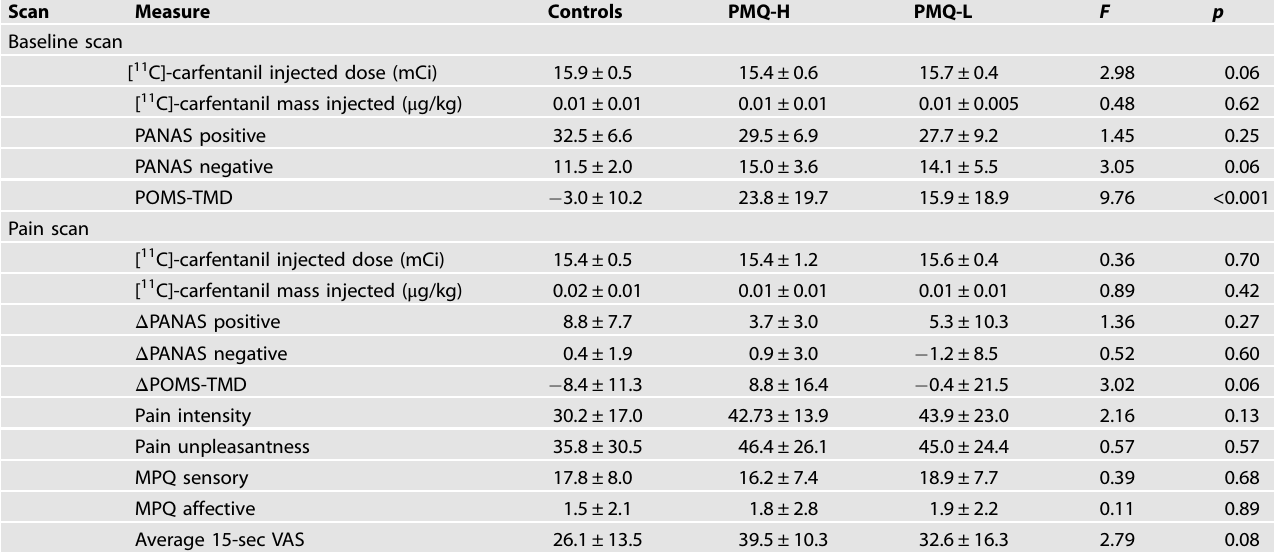
Mean ± 1SD of psychophysical measure of pain during the pain-stress challenge. VAS intensity refers to the average ratings of momentary pain acquired every 15s for the duration of the pain-stress challenge (20 min). The remainder of the scales (MPQ; PANAS; and POMS-TMD) were obtained immediately after completion of the pain-stress challenge.